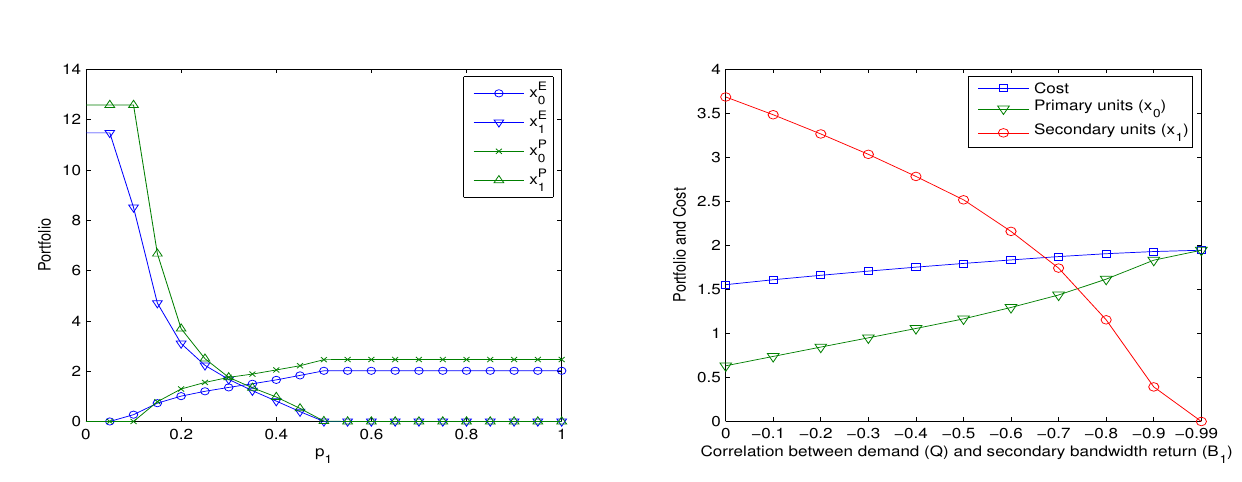
Figure 6. Correlation between demand and secondary return.